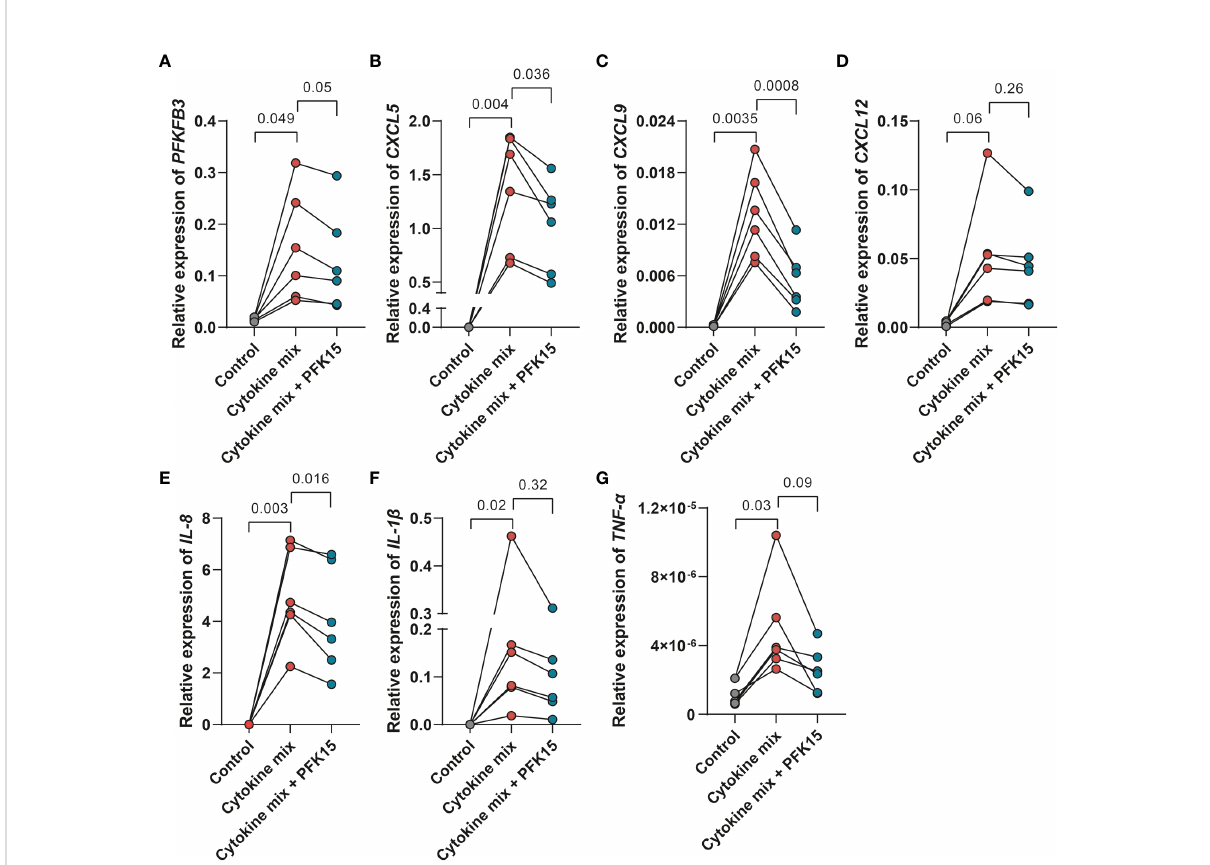
FIGURE 5 PFKFB3 inhibition decreased the expression of pro-in fl ammatory cytokines and chemokines in fi broblasts. Primary fi broblasts (n=6 independent fi broblasts) were stimulated with the UC cytokine mix (IL17-A: 50ng/ml; OSM: 20ng/ml; IL-1 b : 1ng/ml) with or without PFK15 (1 m M) for 24 hours and collected for qPCR analysis. Relative expression (to b -Actin ) of PFKFB3 (A) , CXCL5 (B) , CXCL9 (C) , CXCL12 (D) , IL-8 (E) , IL-1 b (F) , and TNF- a (G) was determined. One-way ANOVA was performed to test for signi fi